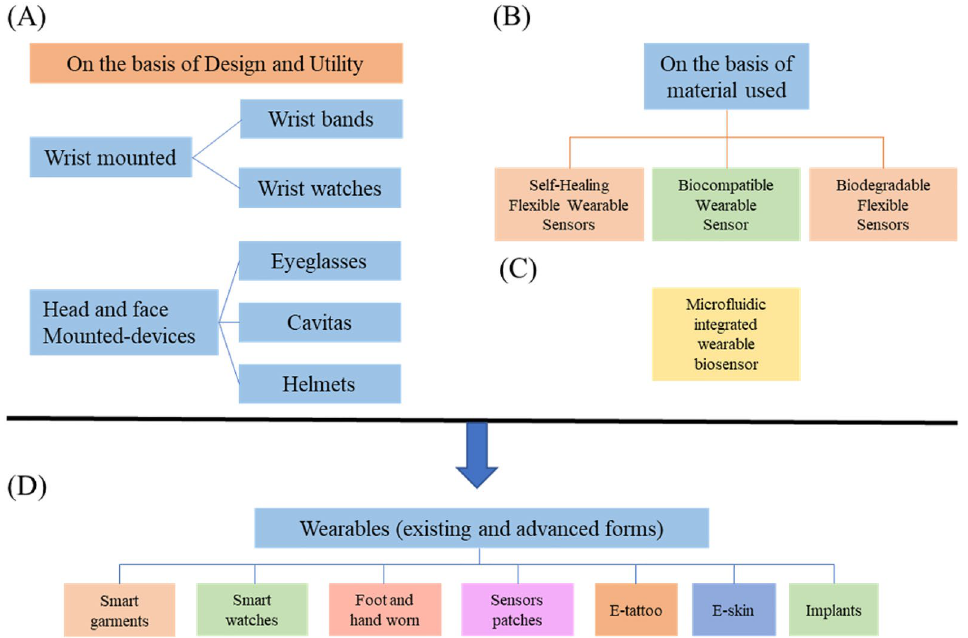
Figure 2. Application principles and categorical examples of wearable biosensors 25